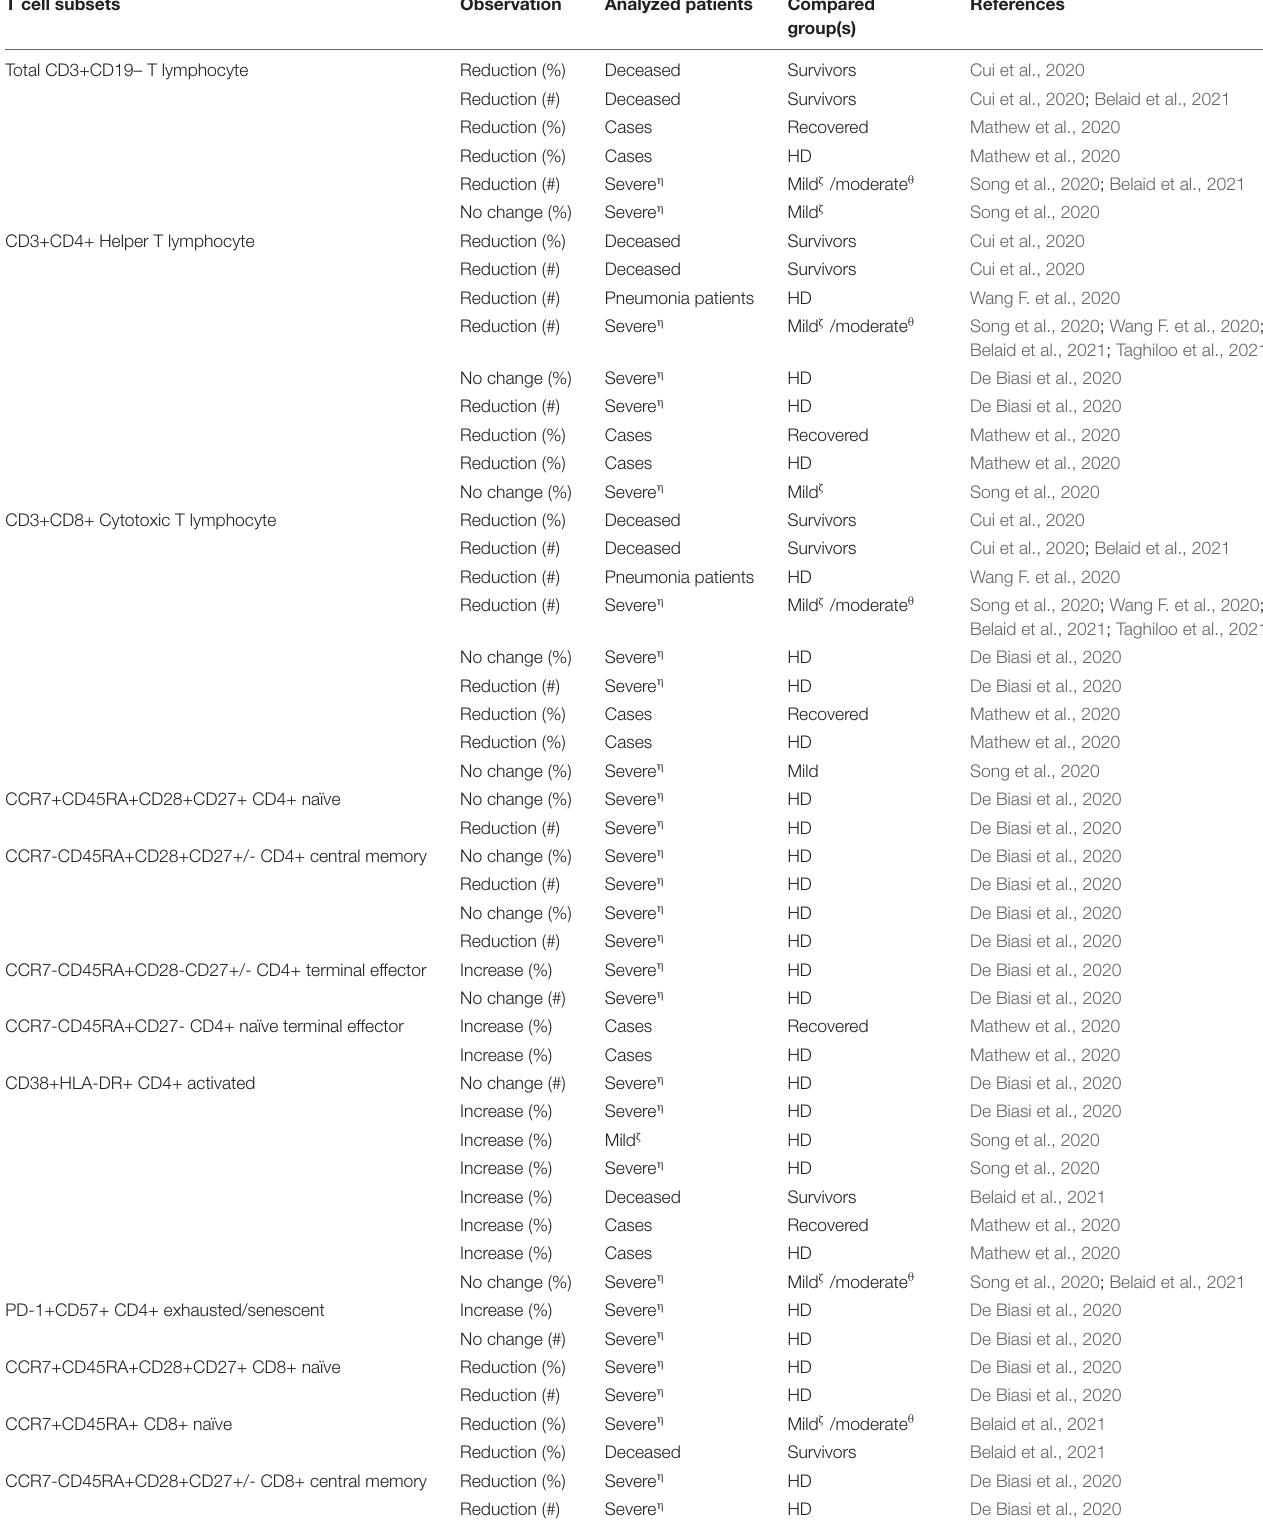
TABLE 4 | Observed fluctuation in T cell subsets in adult COVID-19